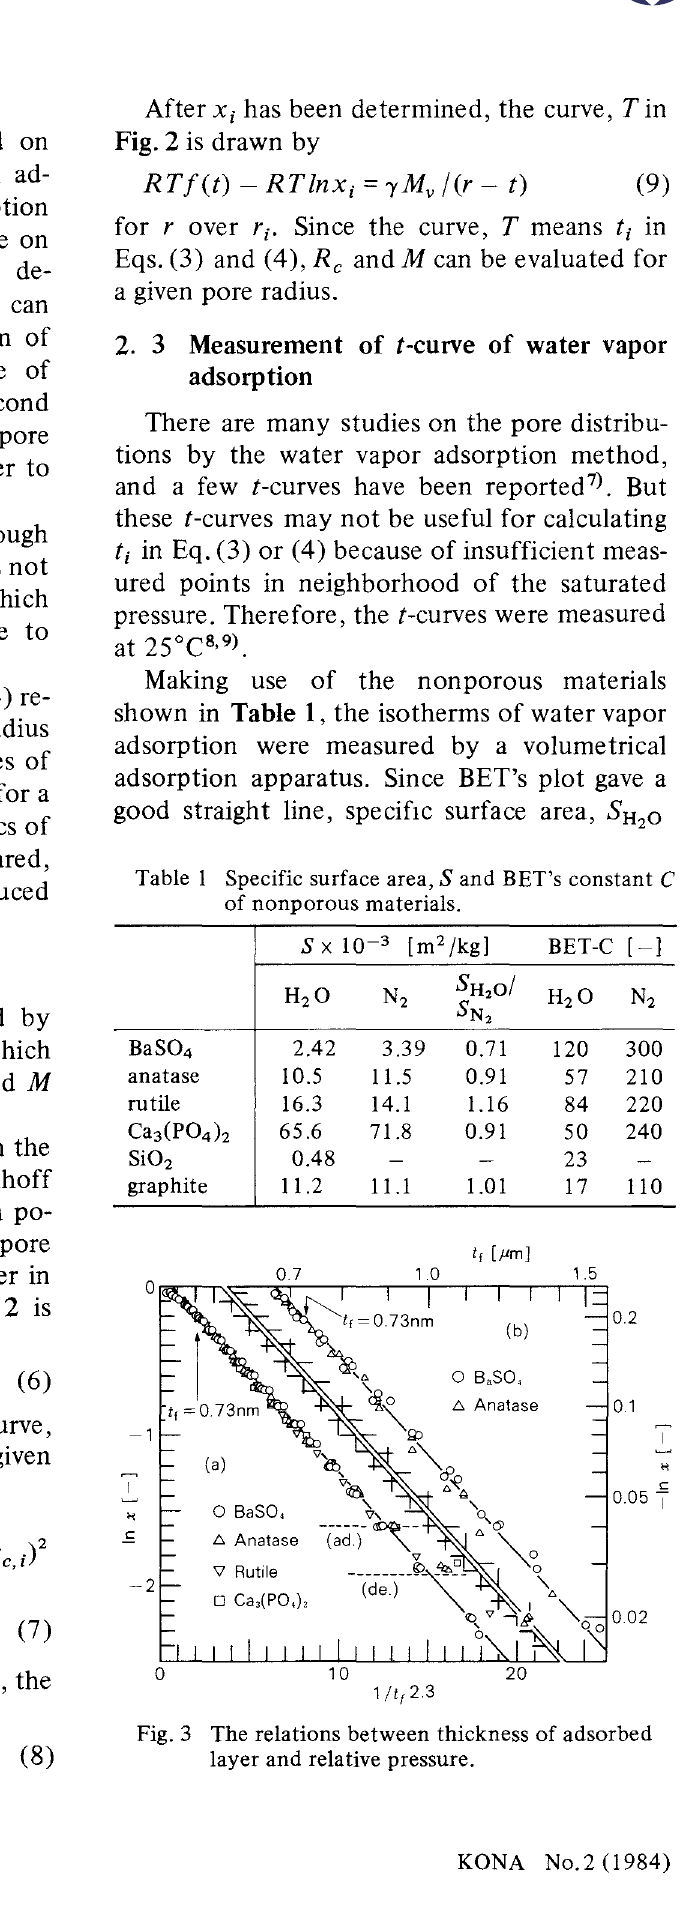
Fig. 3 The relations between thickness of adsorbed layer and relative